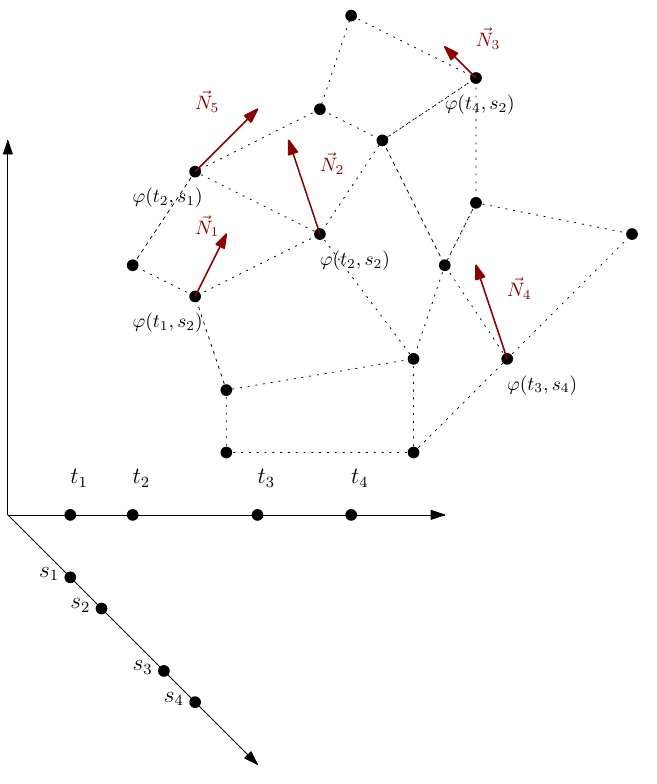
Fig. 1 A finite surface with the patch ϕ on T 1 × T 2